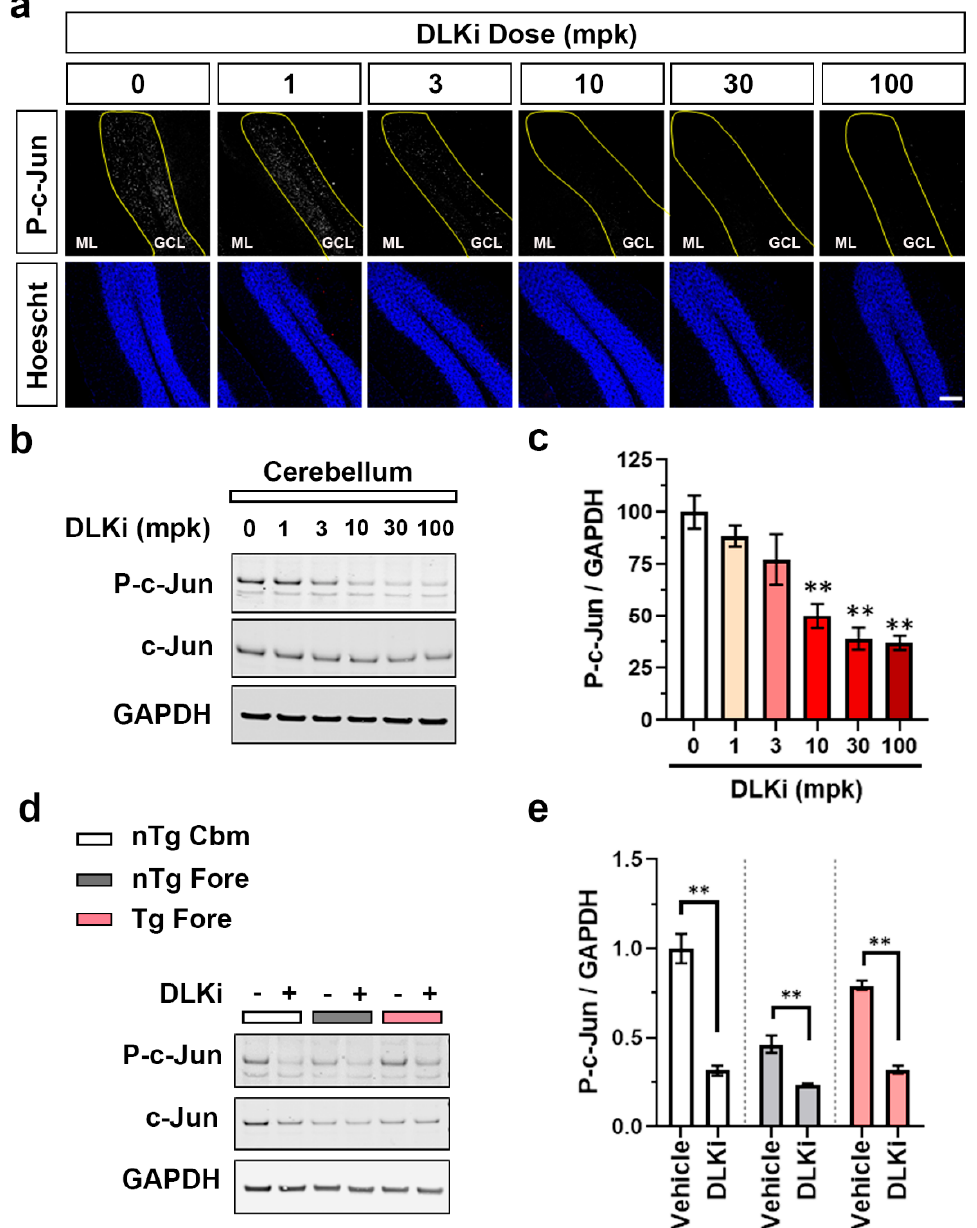
Figure 3. Pharmacological inhibition of DLK inhibits constitutive as well as induced p-c-Jun in adult mouse brain. ( a ) Representative staining for p-c-Jun and Hoechst (blue) in the cerebellum of 3–4 months old WT mice dosed with a single oral dose of vehicle or DLK inhibitor (DLKi) at 1, 3, 10, 30, or 100 mg/kg. ( b ) Representative immunoblots of p-c-Jun and c-Jun in cerebellar homogenates of 3–4 months old male WT mice dosed with a single oral dose of vehicle or DLKi at 1, 3, 10, 30, or 100 mg/kg. ( c ) Quantification of immunoblots of p-c-Jun/GAPDH in cerebellar homogenates of 3–4 months old male WT mice dosed with a single oral dose of vehicle ( n = 7) or DLKi at 1 ( n = 4), 3 ( n = 4), 10 ( n = 4), 30 ( n = 4), and 100 ( n = 4) mg/kg, plotted as percent mean fold change relative to vehicle-treated group. ** p < 0.01, one-way repeated measures ANOVA, followed by Dunnett’s t -test. ( d ) Representative immunoblots of p-c-Jun and c-Jun in homogenates from nTg cerebellum (nTg Cbm), nTg forebrain (nTg Fore), and Tg forebrain (Tg Fore) of 7–8 months old female mice dosed with 50 mg/kg of DLKi or vehicle QD for 7 days. ( e ) Quantification of the immunoblots of p-c-Jun/GAPDH from homogenates obtained from nTg cerebellum, nTg forebrain, and Tg forebrain of mice treated with vehicle or DLKi, plotted as mean fold change relative to vehicle group in respective brain region. n = 6, ** p < 0.01, unpaired t -test.